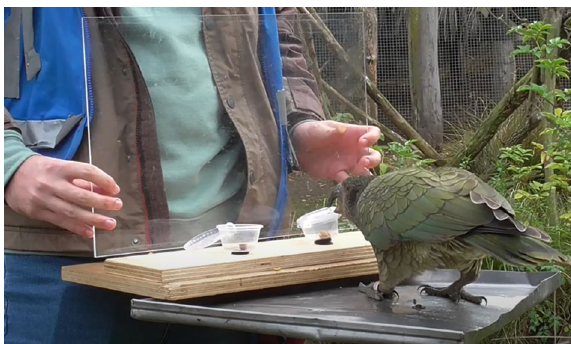
Figure 2. Kea subject performs calculated contrafreeloading during a test